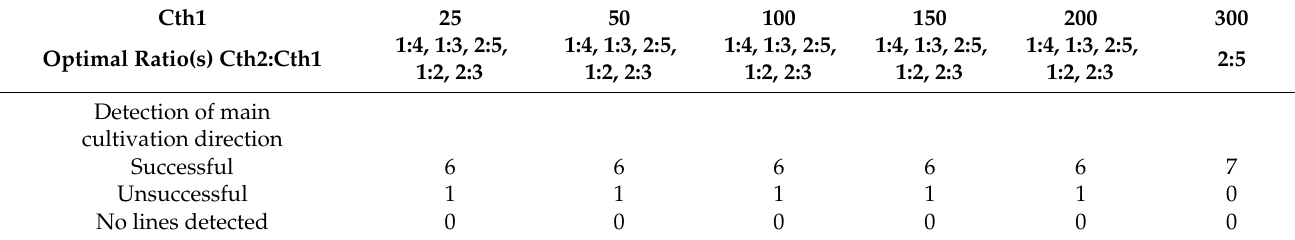
Table 5. Final results of FLD for the whole dataset of seven images with spring barley crop type.